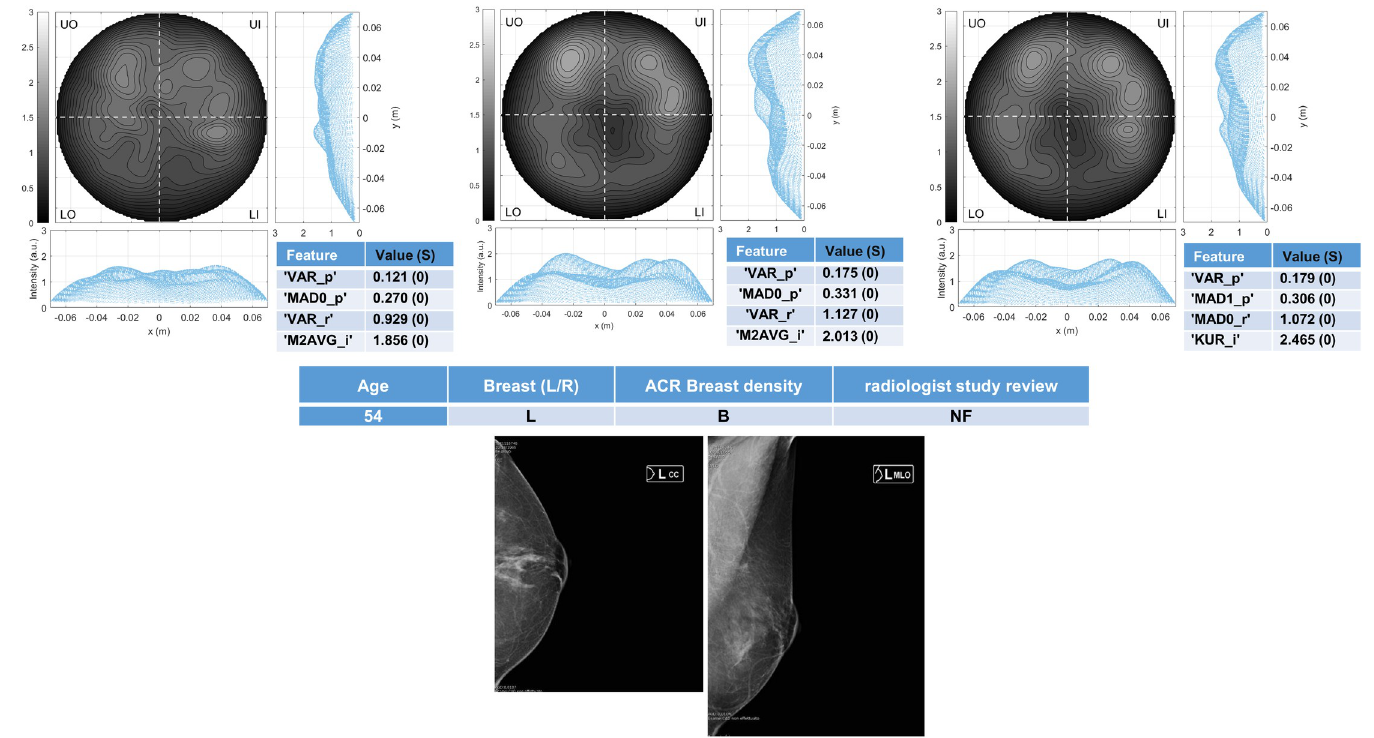
Fig 3. The radiologist study review “NF” for this scattered area of fibroglandular density (ACR B) breast has been obtained with the support of mammography images given in the bottom row. Microwave images, normalized to unitary average of the intensity, are given in the top row for three different conductivity weighting (from left to right: 0.3 S/m, 0.4 S/m and 0.5 S/m, respectively). X and Y are given in meters; intensity is in arbitrary units. All microwave images show a quite homogeneous behavior. The binary score S (given in the inserted tables) is 0 for the all the features. The proposed rule-of-thumb classifies this breast as